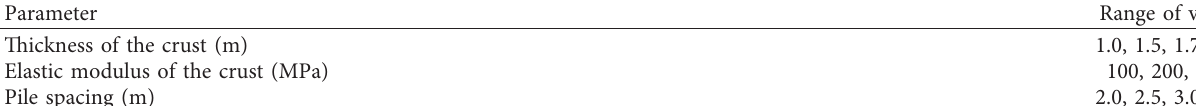
Table 2: Values of influence factors used.